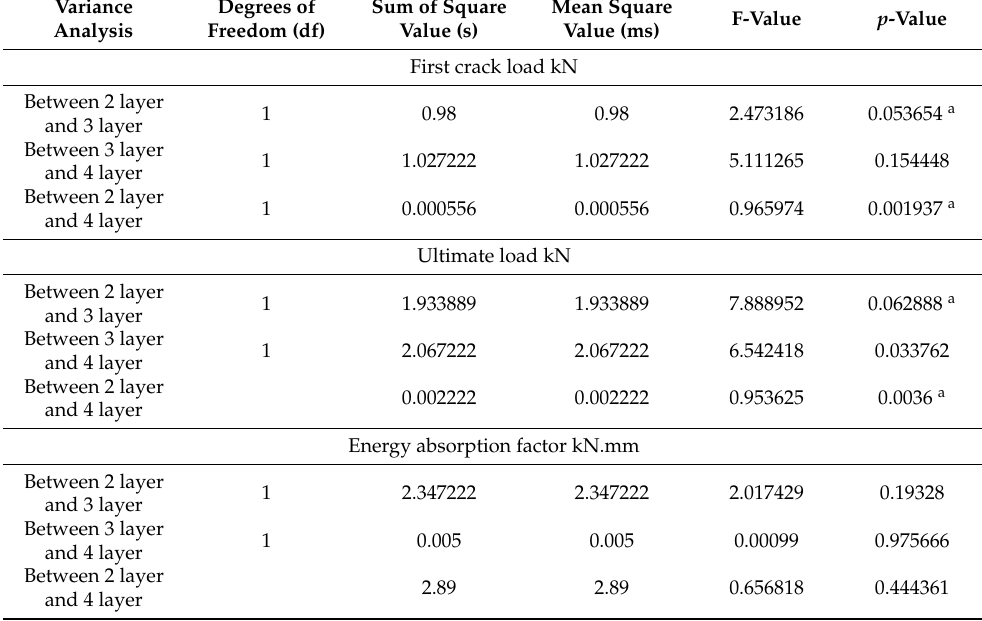
Table 8. Analysis of variance by the number of layers in the reinforcement between marquisette, small sandfly and big sandfly structure reinforced ferrocement